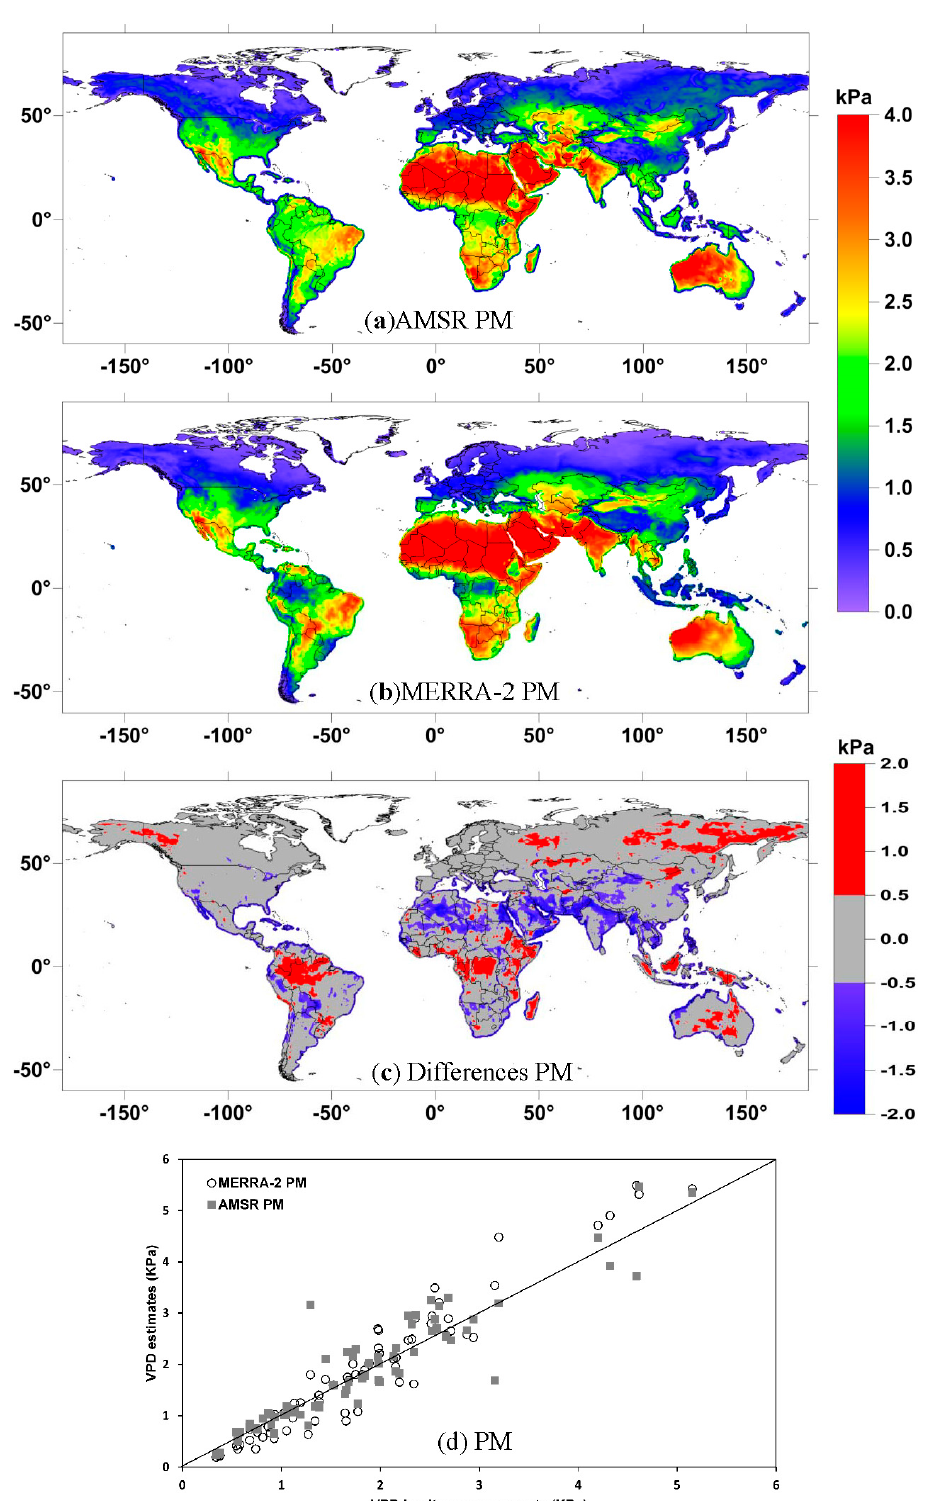
Figure 2. Mean annual Vapor Pressure Deficit (VPD) at ~1:30 p.m. local time derived from ( a ) the Advanced Microwave Scanning Radiometer (AMSR) and ( b ) the Modern-Era Retrospective analysis for Research and Applications, Version 2 (MERRA-2) reanalysis data over 2010; ( c ) the resulting VPD differences (AMSR minus MERRA-2), and ( d ) their comparisons with Integrated Surface Global Hourly (ISH) in-situ measurements.